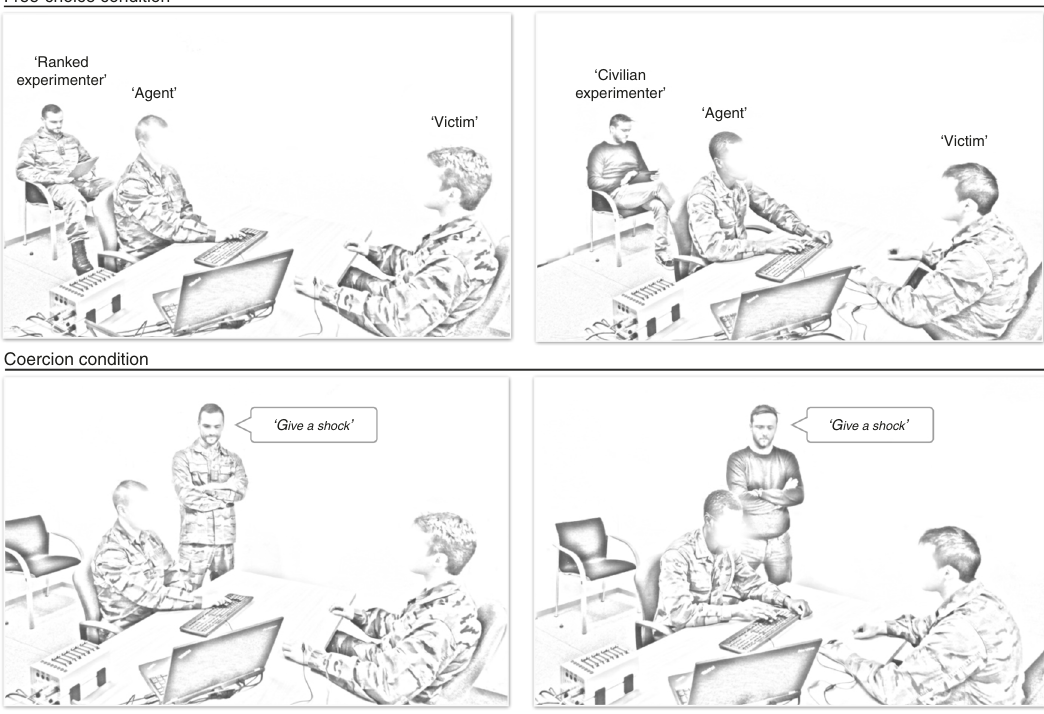
Fig. 5 Schematic representation of the experimental set-up and procedure for the group composed of junior cadets. Note the use of a military experimenter for some dyads, and a civilian experimenter for others. The set-up and the procedure were similar for the group composed of civilian